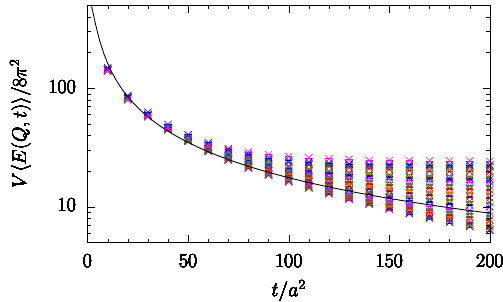
Figure 5. The action V x E p Q , t qy{ 8 π 2 as a function of t { a 2 on the 32 4 lattice for charges ranging from Q “ 0 (bottom) to | Q | “ 22 (top). The solid line represents the ensemble average. No transition from one sector to the other is observed.